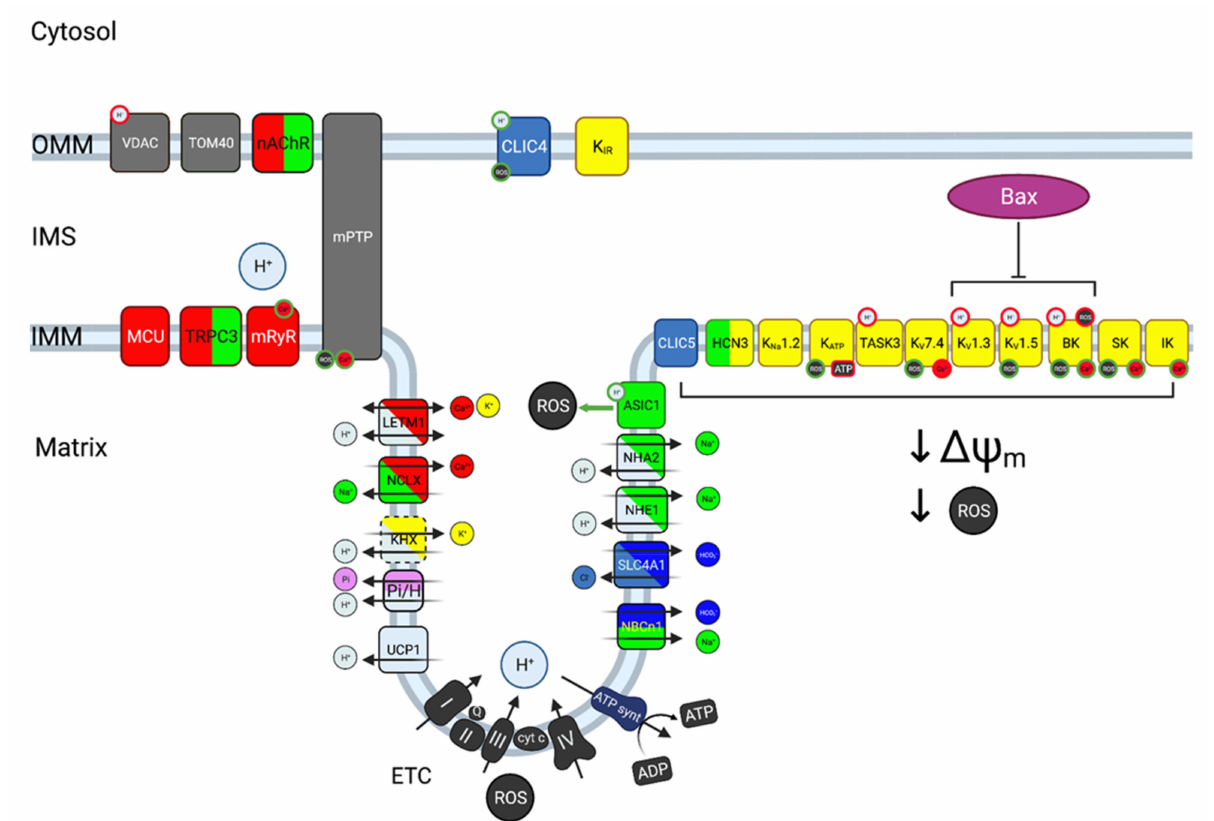
Figure 4. Cartoon representing some of the ion transport proteins detected at mitochondria. The relevant ions are color- coded (K + yellow, Na + green, H + light blue, Ca 2+ red, Cl − blue, HCO 3 − , dark blue, P i − pink). Non-selective channels are represented in the colors of the ions they permeate. For the case of transporters (indicated by arrows), the substrates of exchangers are indicated by the corresponding colors, in parallel for cotransporters and diagonal for exchangers. The dashed line for KHX denotes its disputed identity. Regulating factors are represented by circles on the transport protein, with a green border for activators and a red border for inhibitors. Not all transporters will be represented in a given cell, and some important transporters (e.g., aquaporins) have been